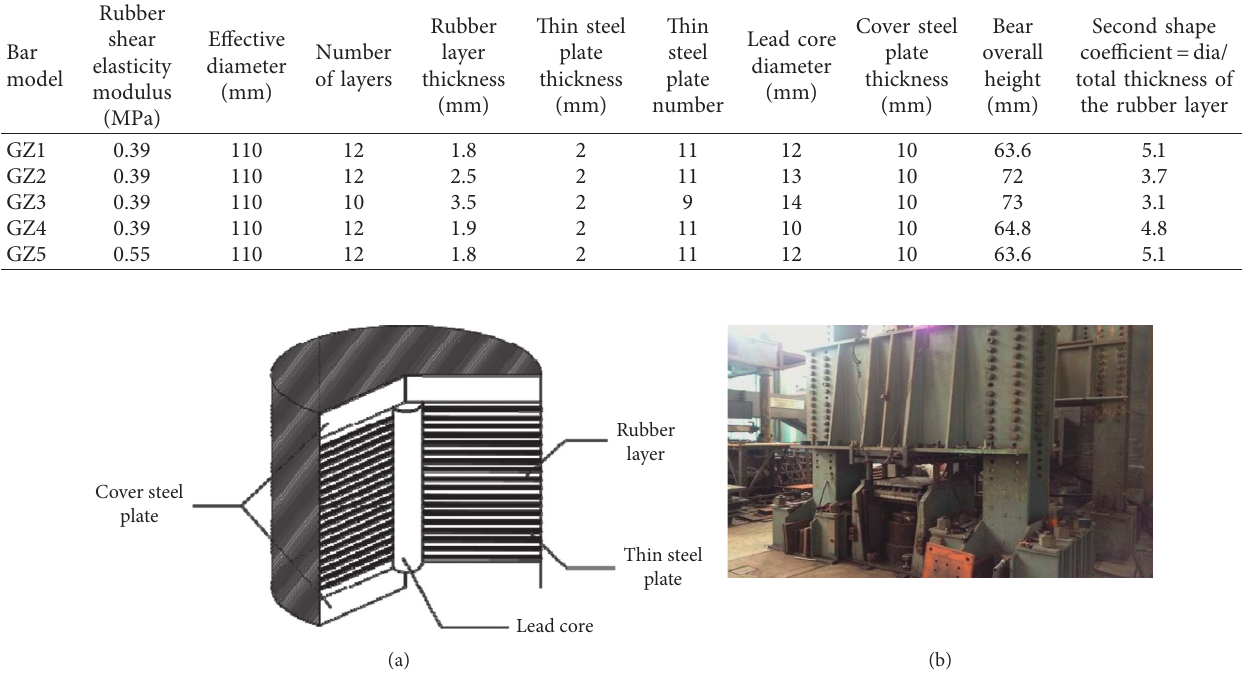
Figure 3: Testing LRB and equipment: (a) dynamic loading equipment; (b)